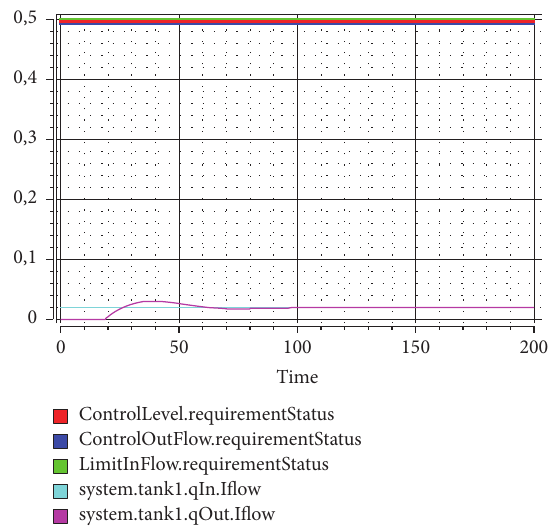
Figure 4: Red, blue, and green lines show the evaluation of requirements that are not violated throughout the execution.